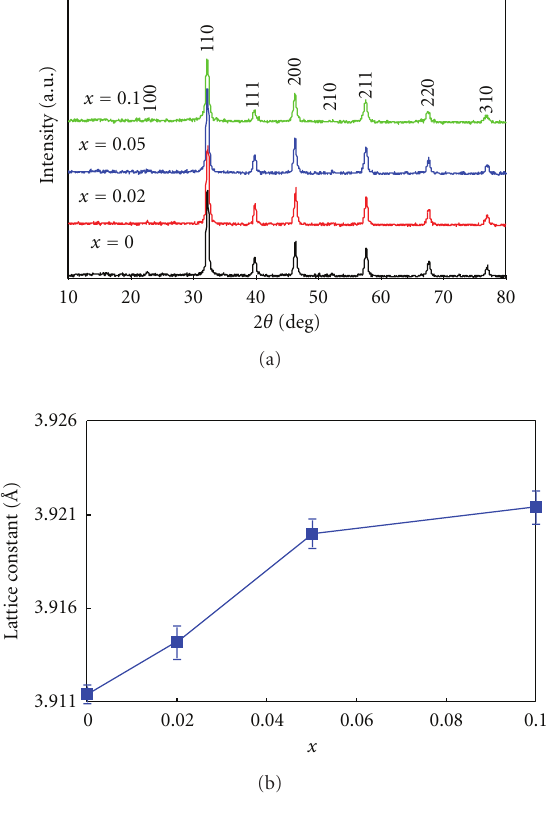
Figure 3: XRD patterns (a) and lattice constant (b) of SrTi 1 − x Ta x O 3 − y N y .